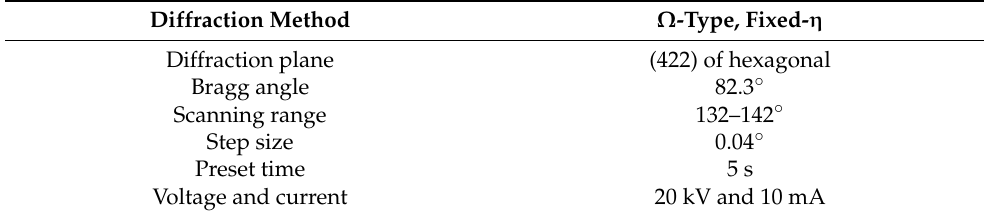
Table 1. The experimental conditions for stress measurement using XRD.